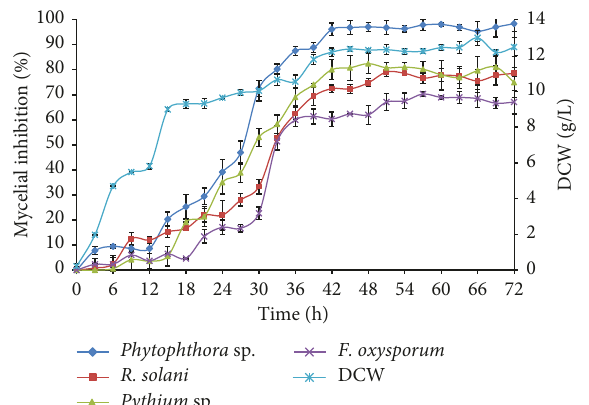
Figure 5: Levels of dry cell weight (DCW) and antifungal activity of X. stockiae PB09 in the optimized medium. The error bars in the figure indicate the standard deviations from three